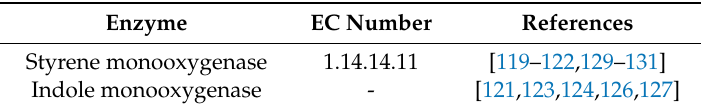
Table 2. Representatives of Group